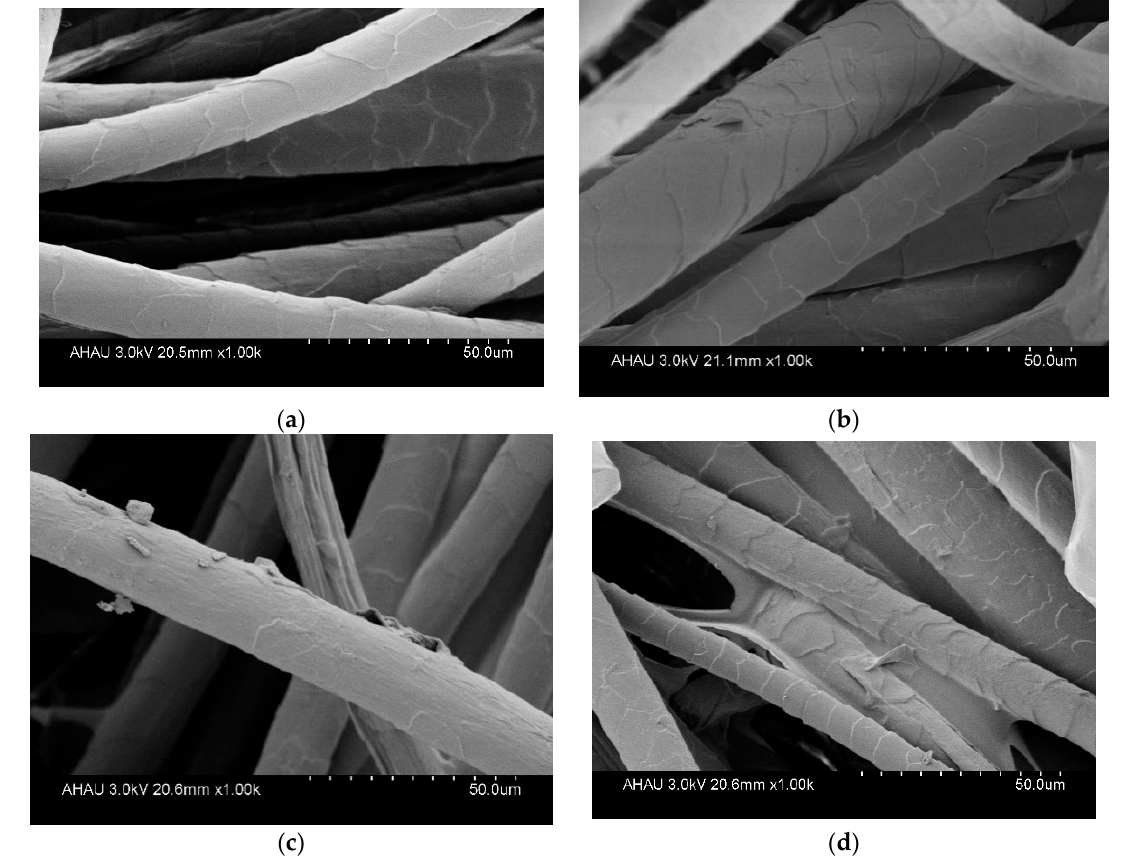
Figure 10. SEM images of cashmere fibers grafted with chitosan: ( a ) untreated cashmere fiber; ( b ) cashmere fiber with graft add-on of 4.34% chitosan; ( c ) cashmere fiber with graft add-on of 6.82% chitosan; and ( d ) cashmere fiber with graft add-on of 9.51% chitosan).